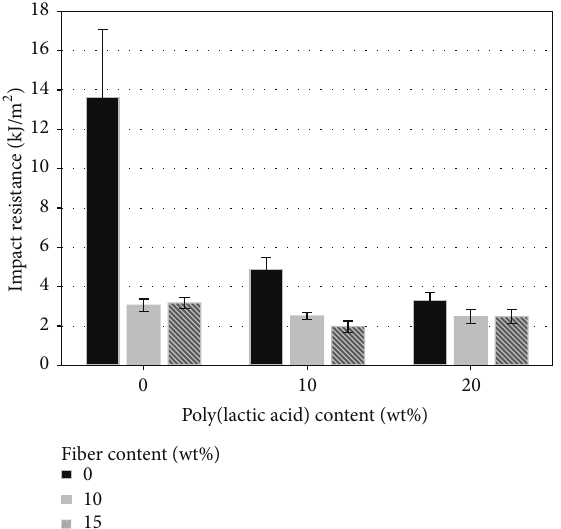
Figure 9: Impact resistance of polymer blends and composites at 25 ∘ C varying PLA content.